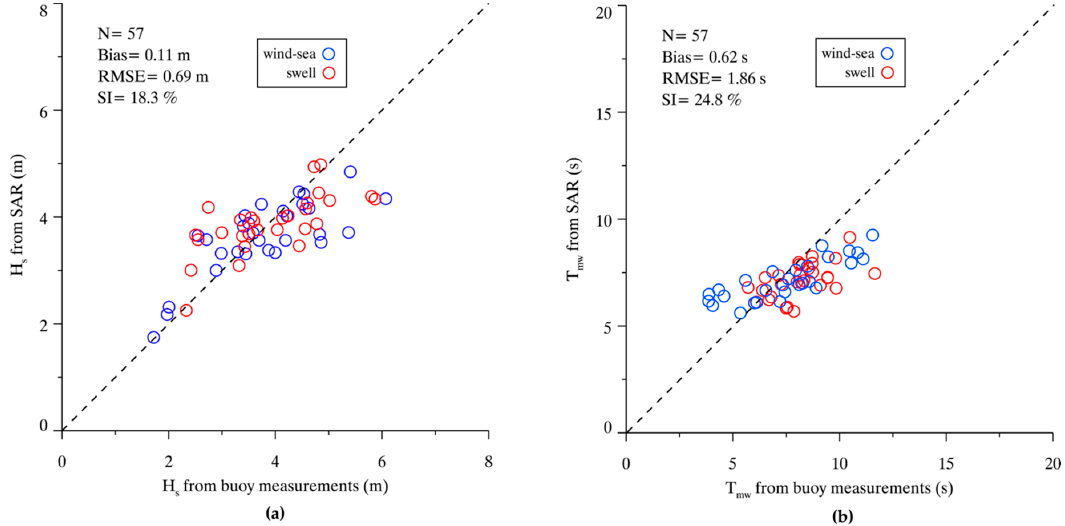
Figure 12. Wave parameters retrieval results from total 57 cases are compared to buoy measurements. ( a ) H s comparisons; and ( b ) T mw comparisons.